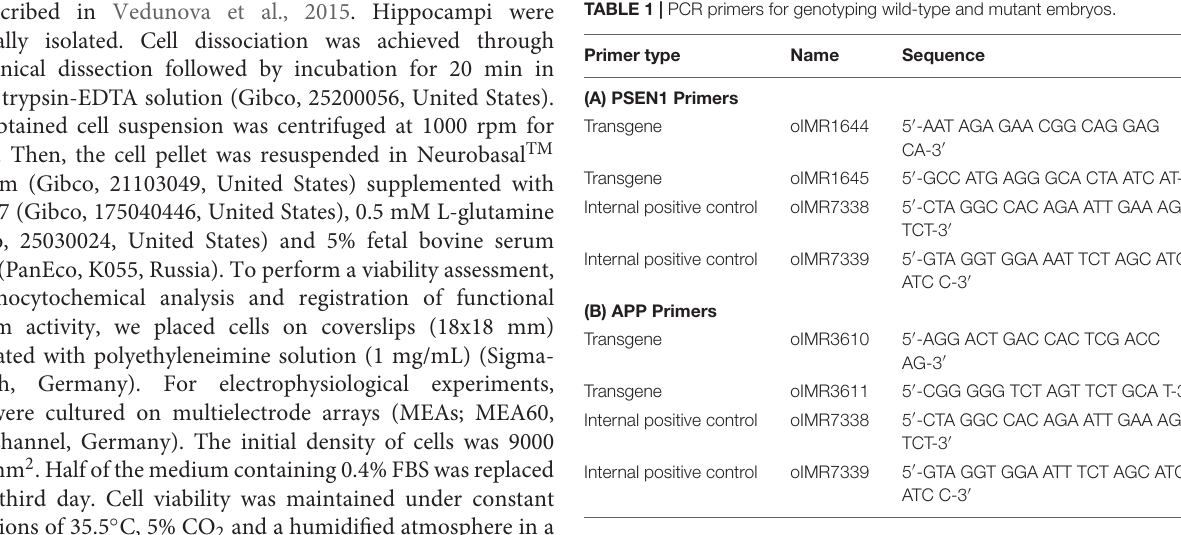
TABLE 2 | Reaction/components for 1